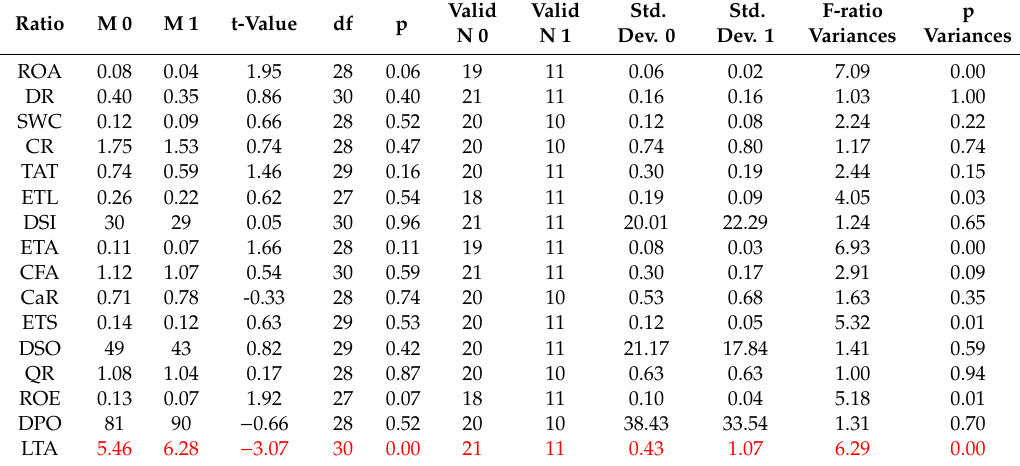
The red color means that di ff erences in the values of individual indicators are statistically significant. Table A8. The student’s t-test results for the chosen ratios for green (1) and red (0) companies for